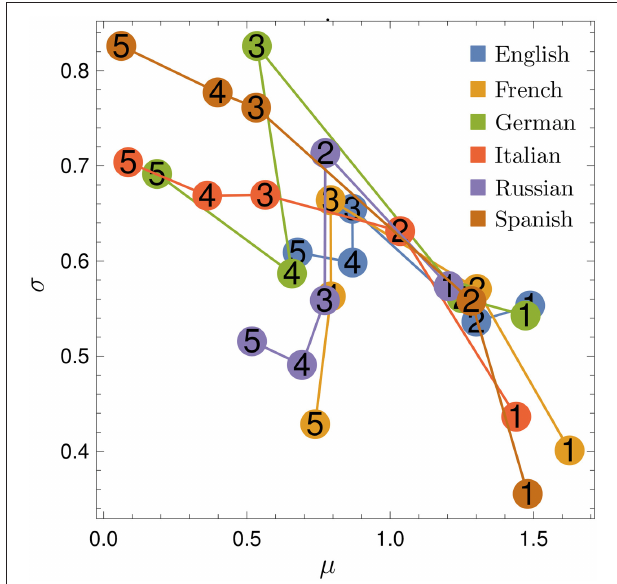
FIGURE 8 | Fitted parameters for change probability. Parameters µ and σ for the sigmoid fit of the change probability p ( k ), for all languages (indicated by colors) and N -values (indicated by numbers).